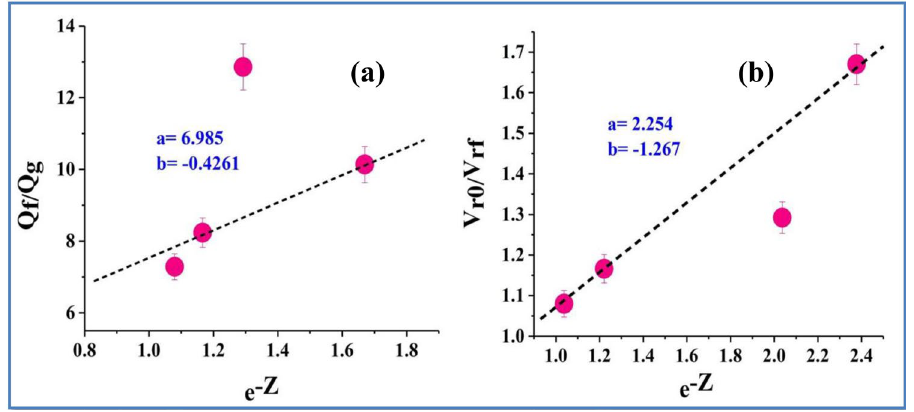
Figure 2. ( a ) Lorenz-Park fitting and ( b ) Cunneen-Russell plot of XNBR-FLG nanocomposites prepared by microfluidizer using chloroform as